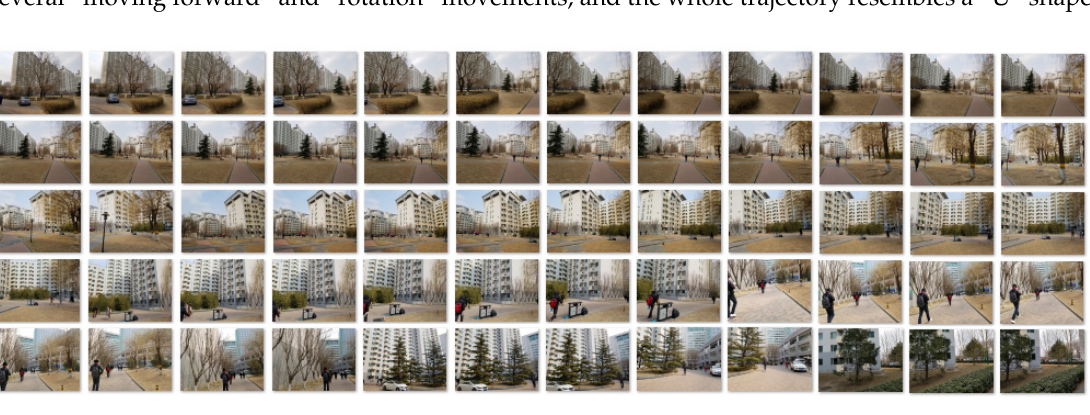
Figure 14. AlphaMEX CNN-based location estimation result from New Main Building to Concert Hall. Each dot in the chart represents the confidence of each frame with different colors representing scene classes (shown in the legend). The period represents the walking distance, with the wearer walking with constant speed.